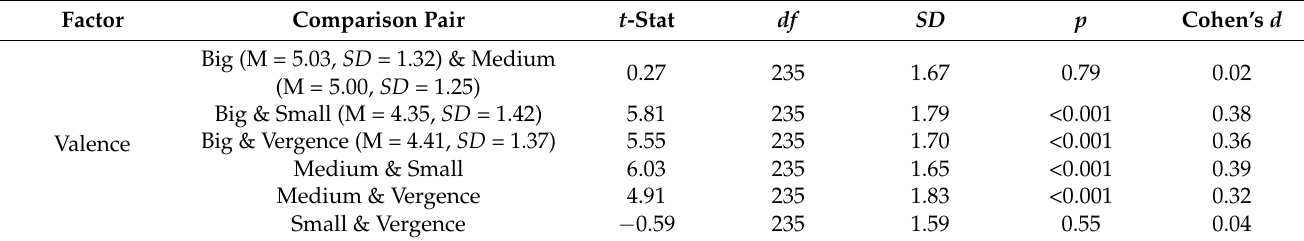
Table 4. Post-hoc comparisons for valence ratings in Experiment